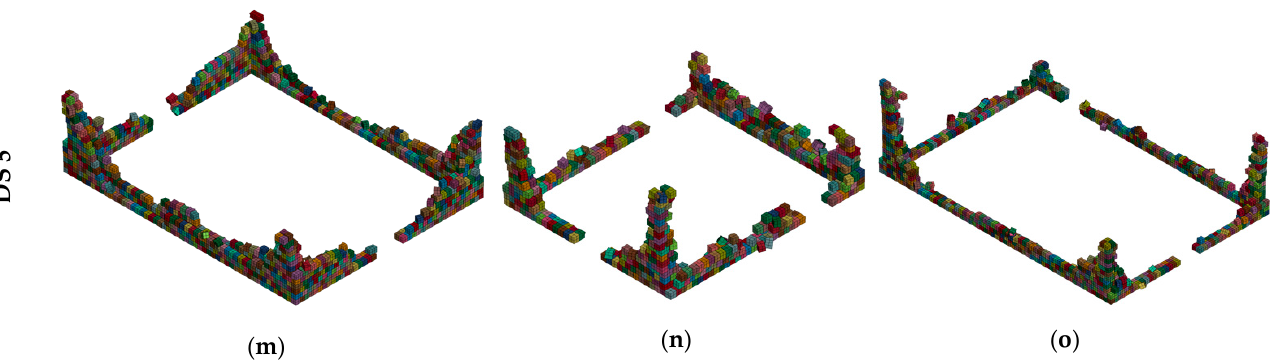
Figure 13. Crack formation and volume loss shown at the end stage of the non-linear time history analyses sustained by buildings 1–3 for the 5 damage states: ( a , d , g , j , m ) building 1; ( b , e , h , k , n ) building 2; ( c , f , i , l , o ) building 3.